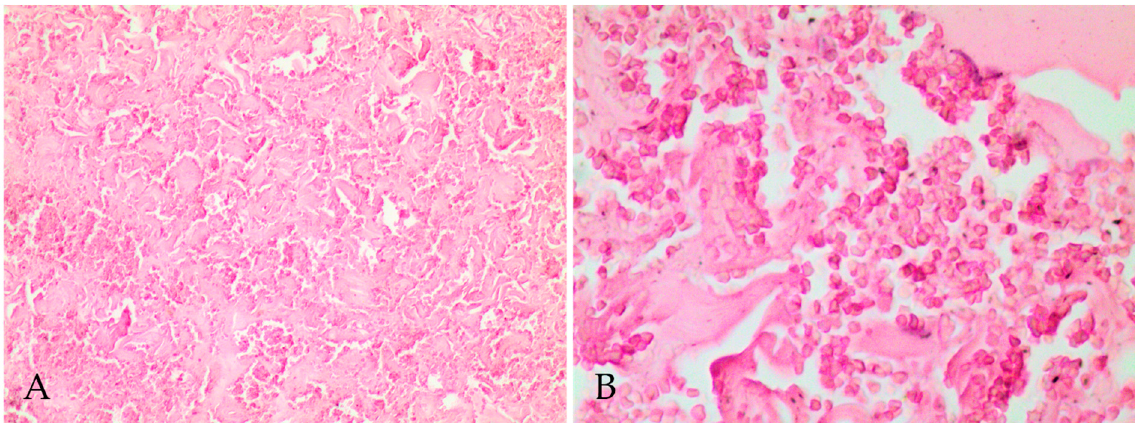
Figure 5. Photomicrographs of implant polymer site removed 57 weeks after implantation. No polymer was identified at this time ( A ) Site of implantation with abundant disorganized collagen fibers, no integral or fragmented polymer material or fibrotic capsule and intense diffuse hemorrhage. ( B ) Site of implantation evidencing the intense diffuse hemorrhage, characterized by many erythrocytes out of vessels. Hematoxylin and eosin; 100× ( A ) and 400× ( B ). Table 1. Score classification of the histopathological lesions in the implant samples at each surgical removal time of a horse implanted with six polymers of poly(lactic acid) (PLA). Intensity of lesions was classified as mild (1), moderate (2), marked (3), and severe (4).